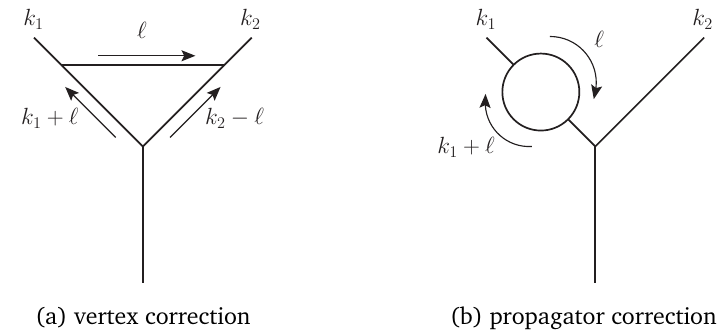
Figure 6: Assignment of momenta in generic virtual graphs to the left of the cut. An analogous assignment holds for loops to the right of the cut, with k by + ∆ and − ∆ ,